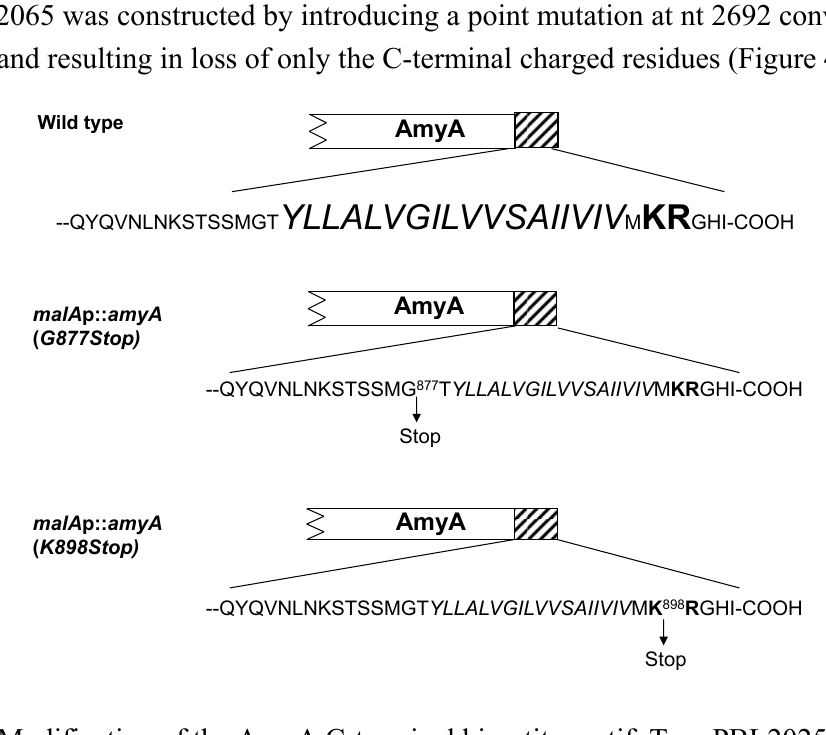
Figure 4. Modification of the AmyA C-terminal bipartite motif. Top, PBL2025 (wild